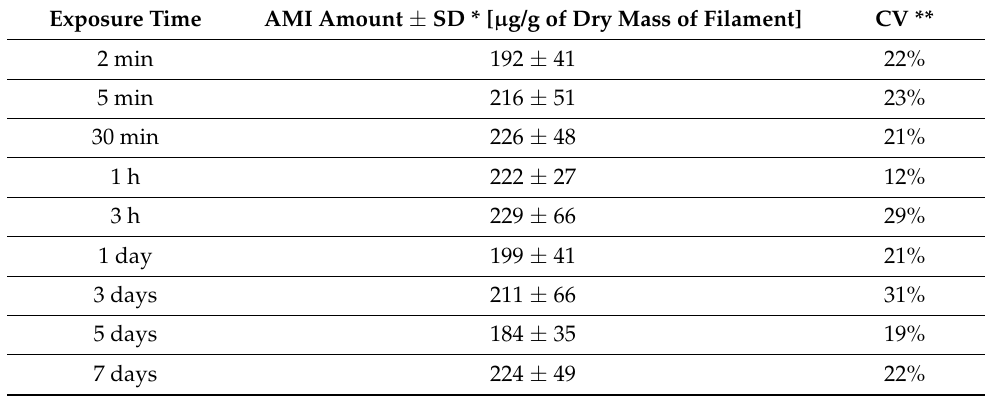
Table 4. Amount of amikacin (after its release from filament AMI-1 into water